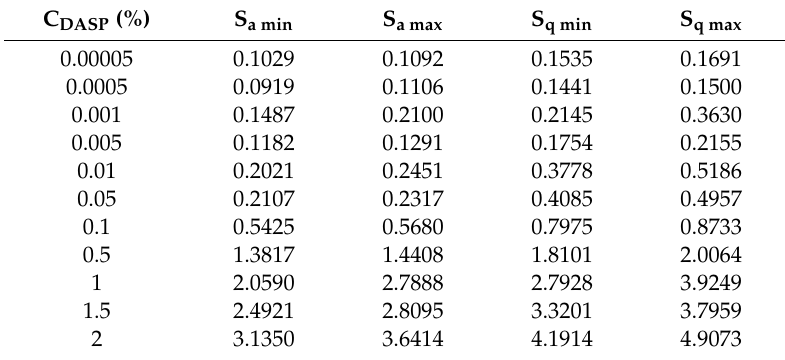
Table 1. The surface roughness parameters of AFM images—average roughness (S a ) and root mean square roughness (S q ). The minimum and maximum values of these parameters are